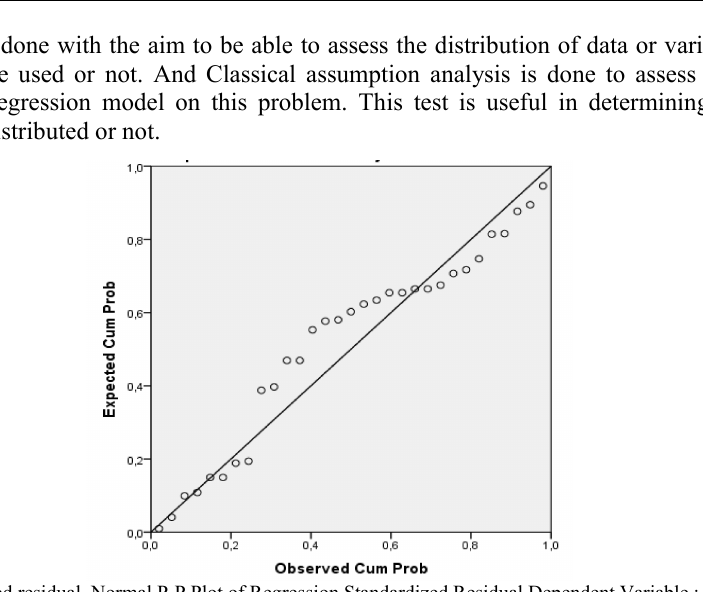
Fig 4. Regression standardized residual, Normal P-P Plot of Regression Standardized Residual Dependent Variable : Risk Management Fig. 4. shows that the coordinates point around the diagonal line and follow the diagonal shape so that the